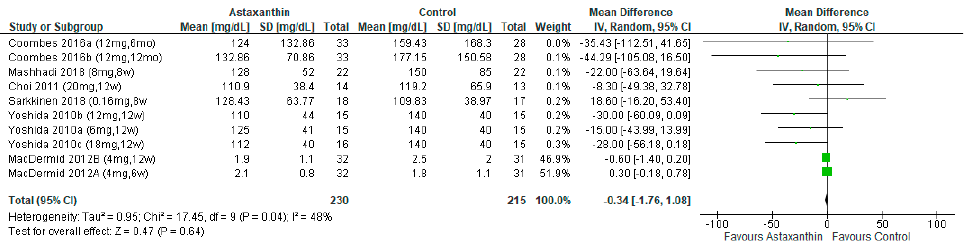
Figure 9. Forest plot of the effect of astaxanthin on triglyceride [26,28,29,30–32]. Bold means total data.